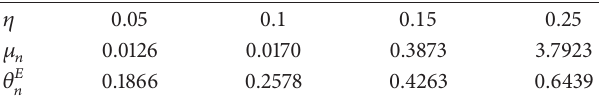
Table 4: Einstein rings and magnifications ( 𝑛 = 2 ) for phantom global